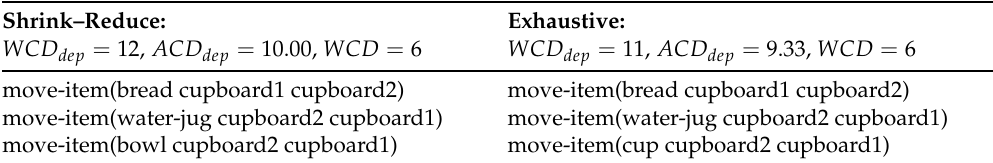
Table 1. List of state change actions returned by the Shrink–Reduce and Exhaustive methods, that when applied to the initial state ( I ) result in the designed environment. The initial WCD dep = 14, ACD dep = 11.00, WCD =